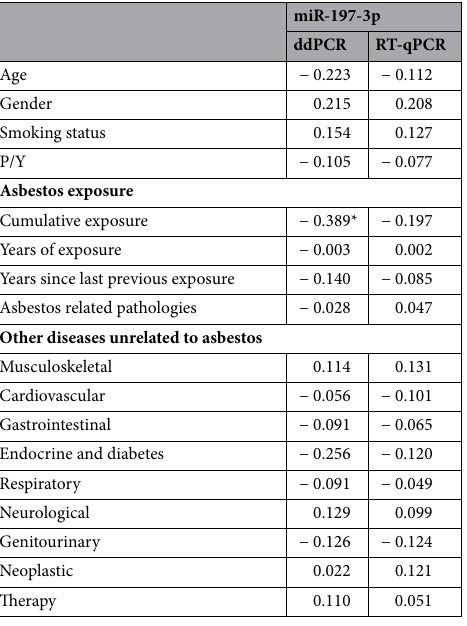
Table 3. Correlation coefficients between miRNA expression and independent variables in the WEA cohort according to Spearman. Correlation coefficients were determined according to the Spearman test. miRNA levels were expressed as copies/µl of analyzed cDNA. Correlations with p < 0.05(*) were considered statistically